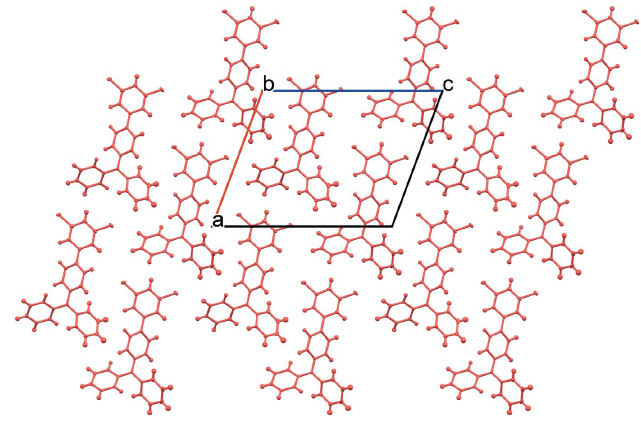
Figure 4 Single sheet of the title compound viewed along [010].